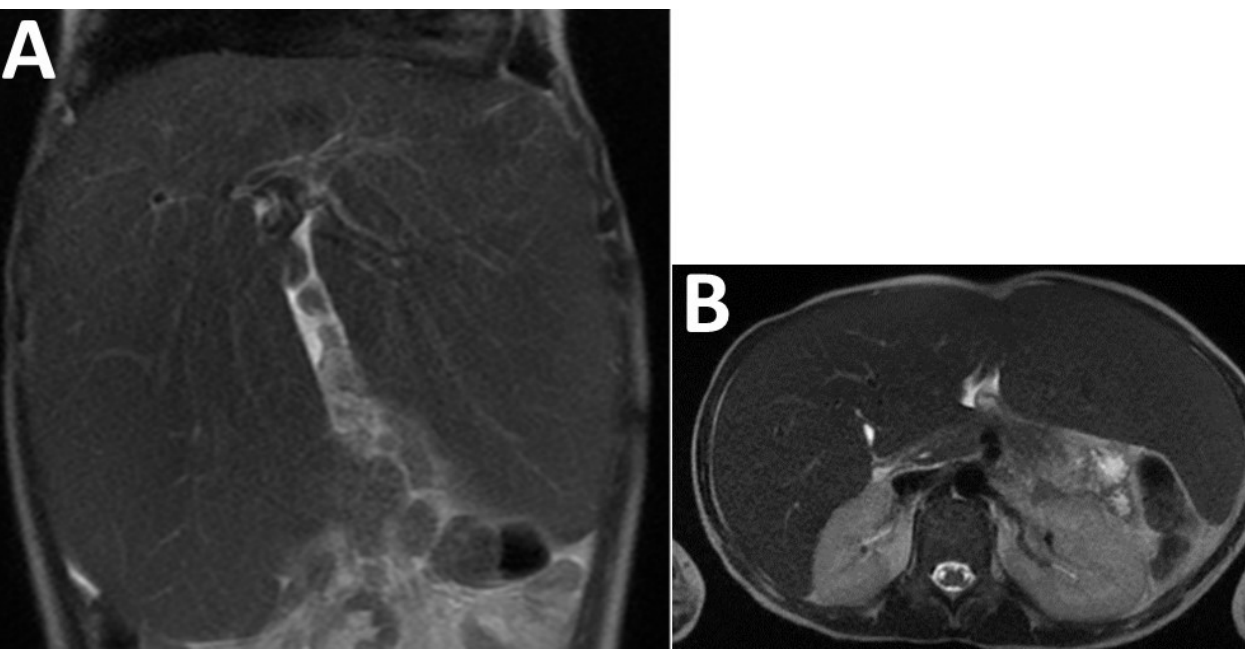
Figure 3. Liver with signs of fibrosis. A : Coronal T2-weighted SSFSE image. B : Axial T2-weighted SSFSE